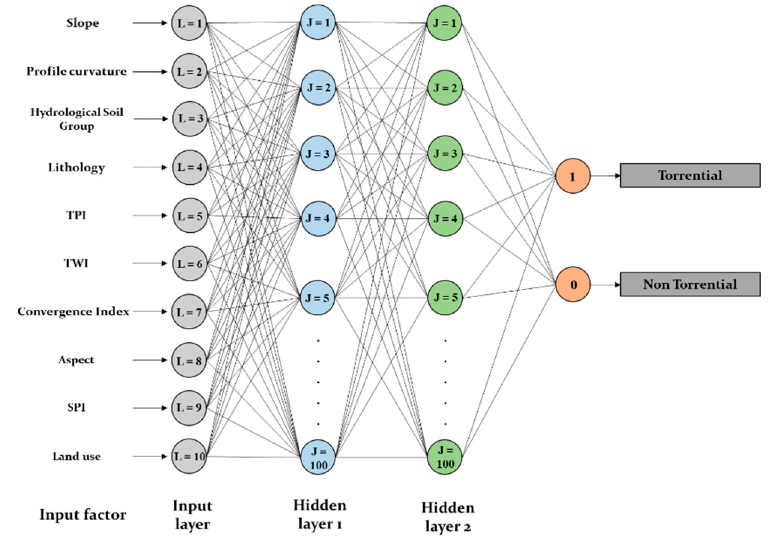
Figure 8. Deep Learning Neural Network architecture.